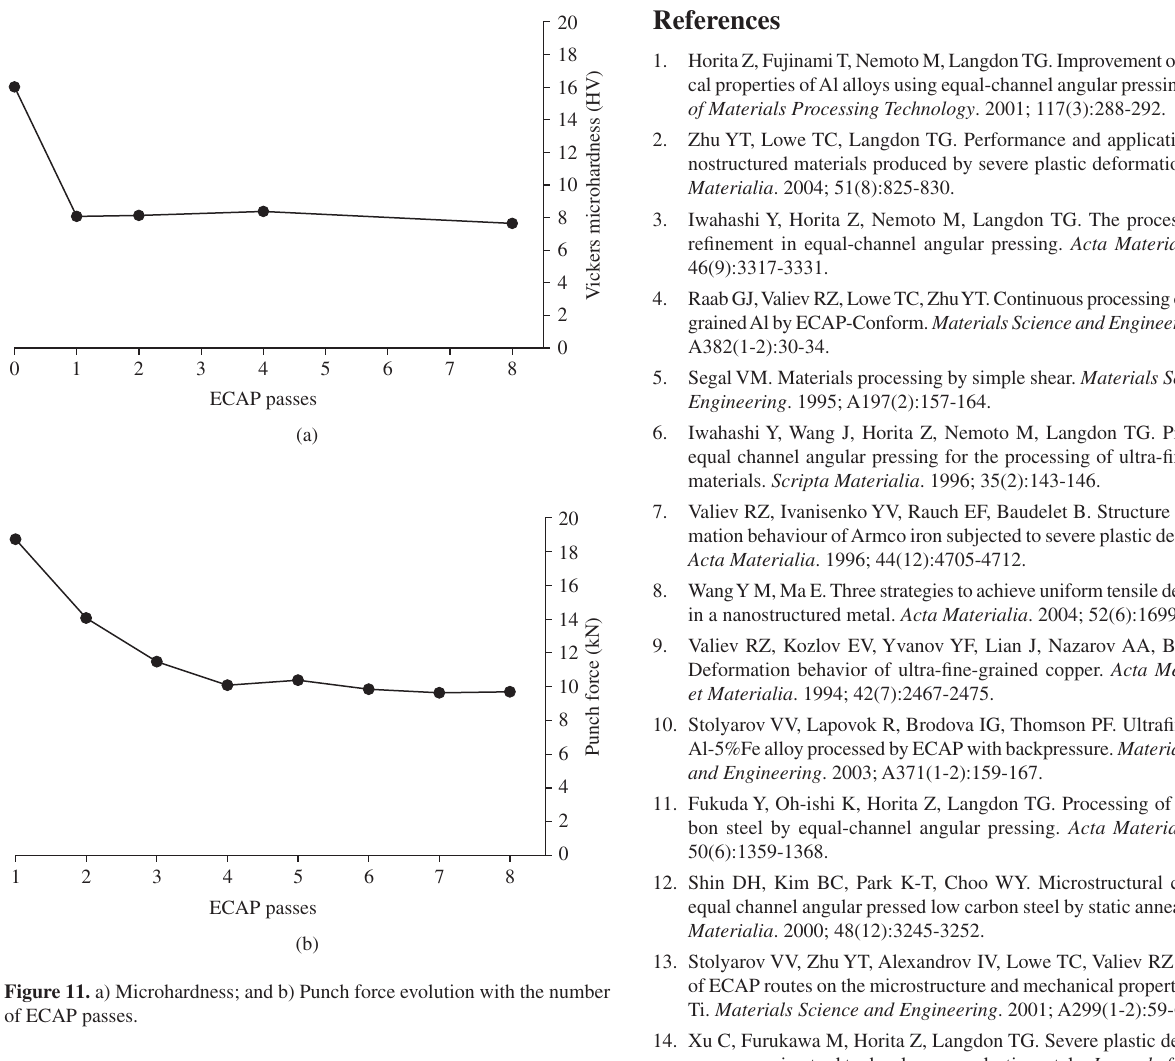
observed, and finer grains prevail in regions were small, grouped precipitates